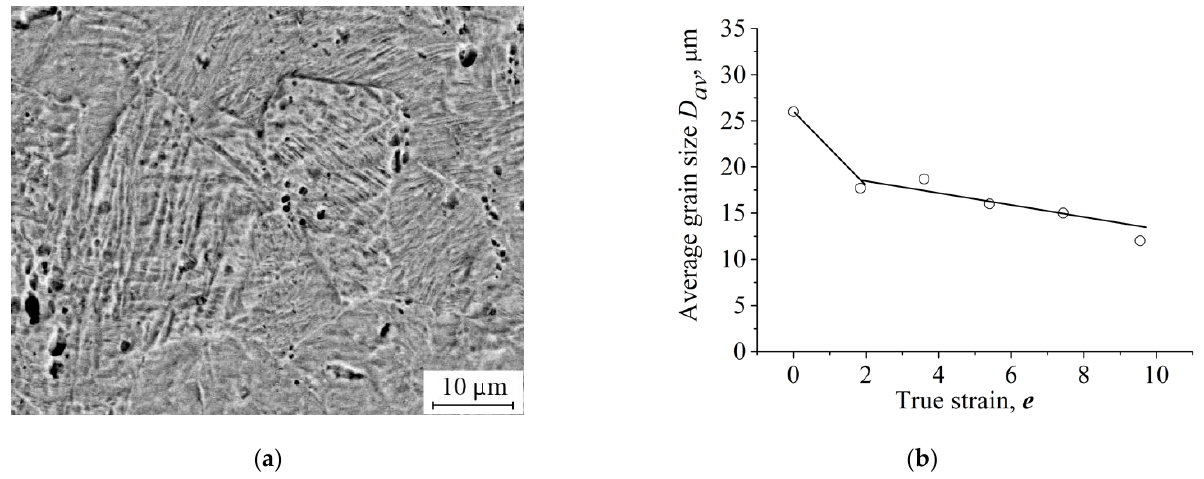
Figure 6. SEM image of Ti 49.8 Ni 50.2 with a true abc strain e = 5.4 ( a ) and e dependence of the average grain size D av ( b ).